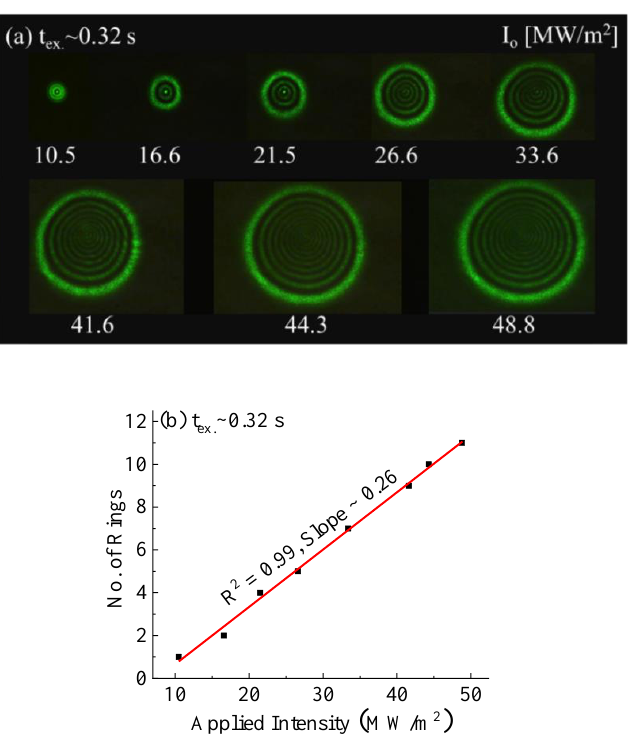
Figure 3. Typical SSPM diffraction patterns at the far field of a Gaussian beam ( a ) through the GO in aqueous base solution for different applied intensities [MW/m 2 ] and ( b ) the number of diffraction rings as a function of applied intensity. The excitation time duration was t ex. ~ 0.32 s.